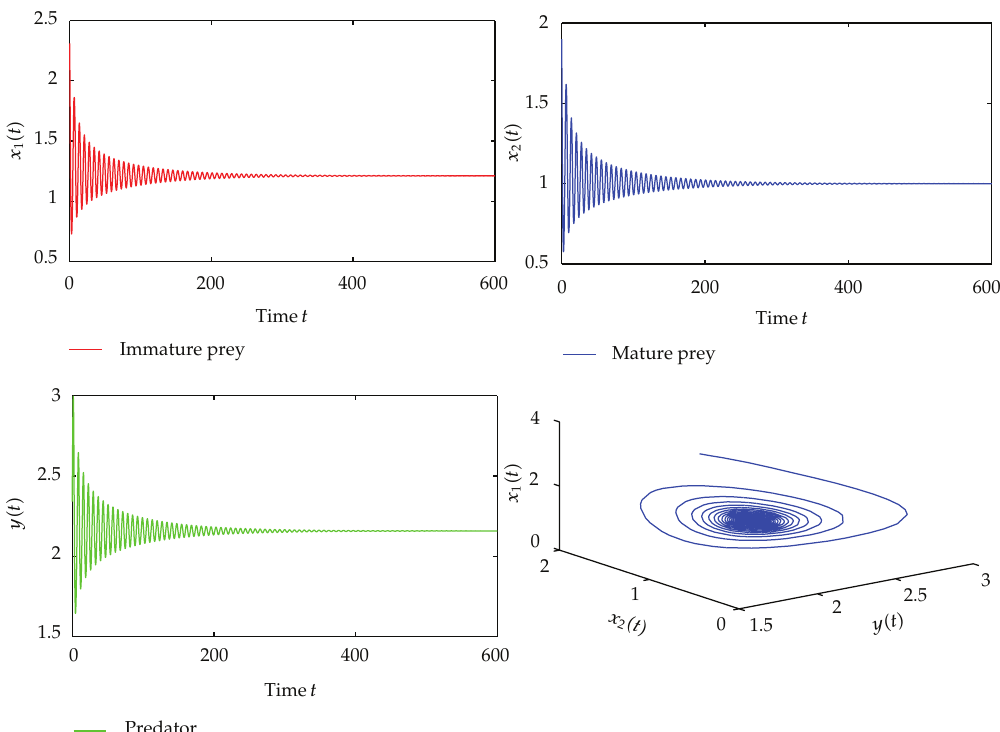
(cid:6) 0 . 5094 and τ (cid:7) (cid:6) 0 . 15 with initial 2 ∗ 1 ∗